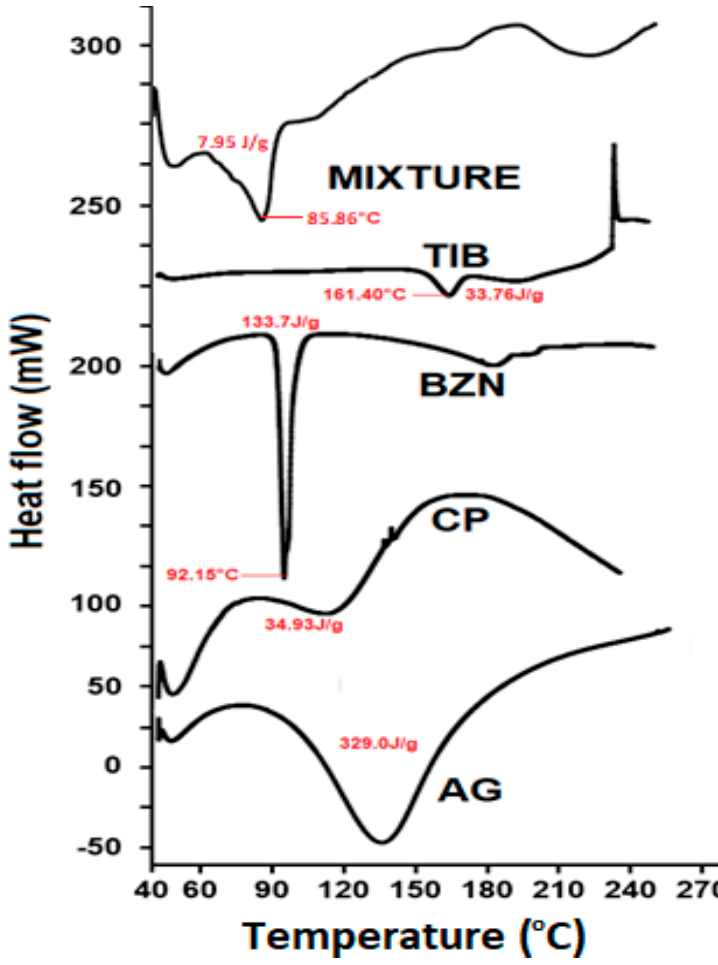
Figure 5. DSC thermogram of AG, CP, TIB, BZN and the physical mixture of the drugs and poly-